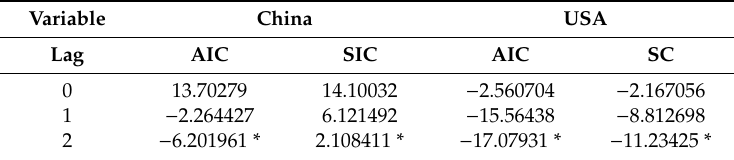
Table A4. Lag selection criteria of